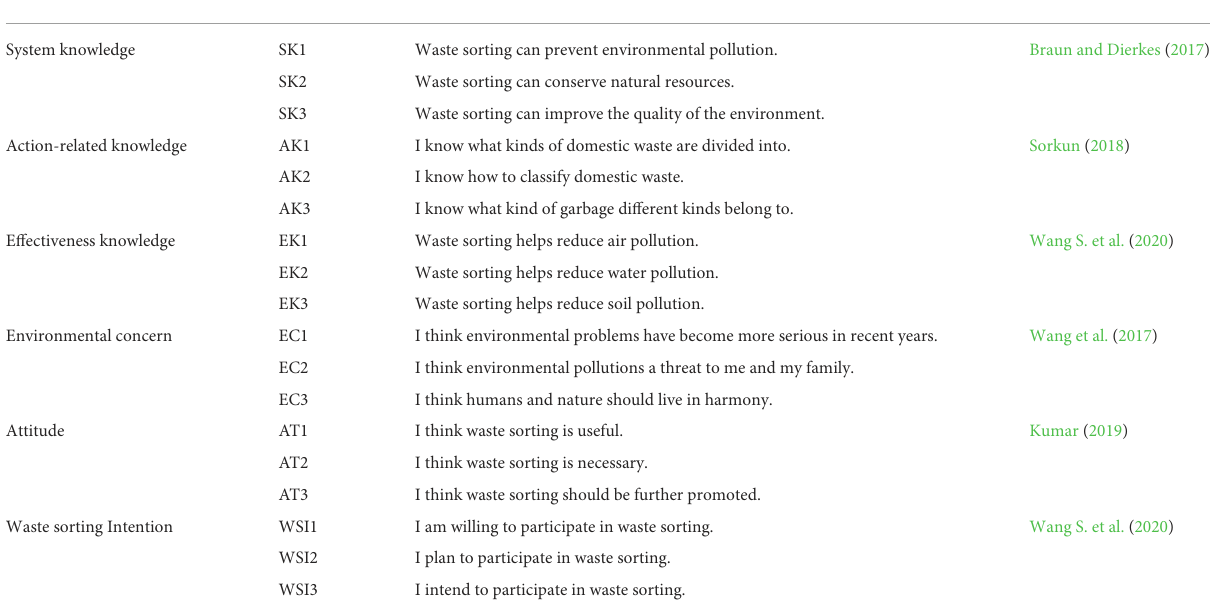
TABLE 1 Questionnaire